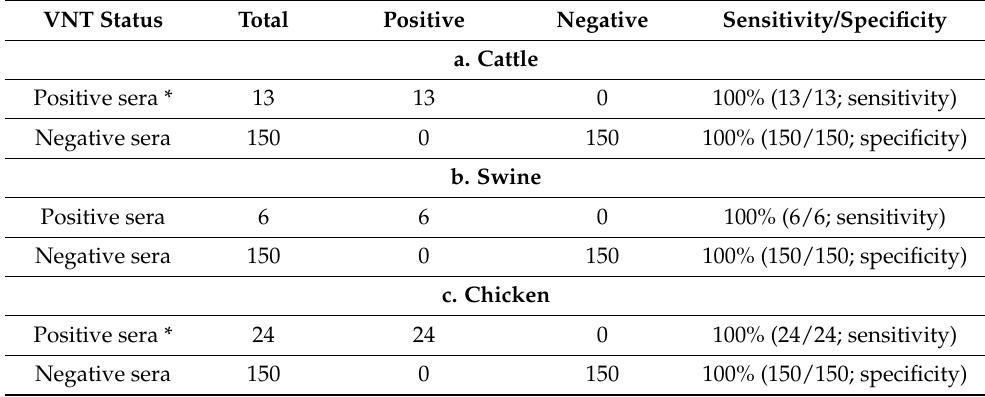
Figure 1. Performance of iELISAs on the serum samples collected from cattle, swine, and chicken. Pre-pandemic (known negatives) and pandemic-era serum samples from domestic animals were tested on species-specific iELISAs for cattle, swine, and chicken. The cut-offs of the iELISAs were determined by testing pre-pandemic sera from each species. Hyperimmune serum (HIS) samples were used as positive controls for the ELISAs. Bar heights represent the mean absorbance of the samples read at 450 nm. Error bars represent the standard deviation. Dashed lines indicate the cut-off for each of the assays. Table 1. Estimation of sensitivity and specificity of iELISAs.